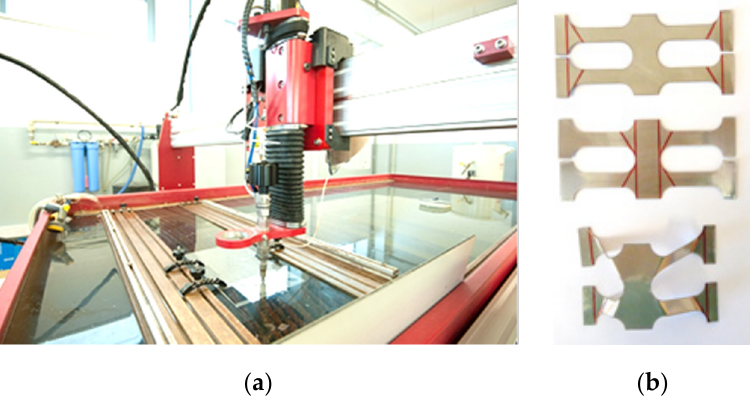
Figure 5. ( a ) Manufacturing method of the perforated profile ( b ) specimens used for the experimental testing.